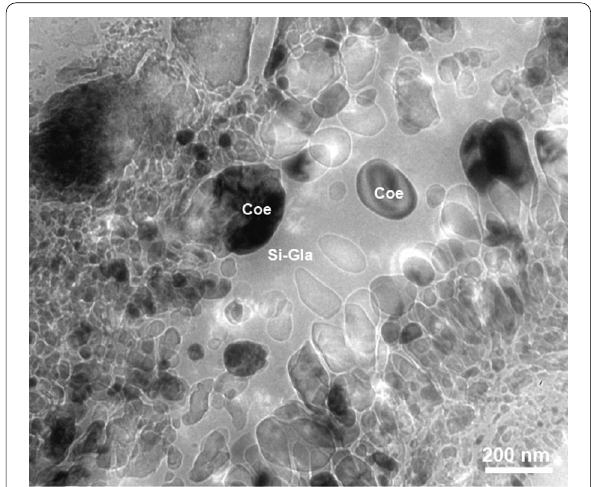
Fig. 10 BF-TEM image of coesite in the eucrite Béréba. Spherical coesite crystals have formed in cristobalite or tridymite grains in contact with the shock-melt veins of Béréba. A part of the original silica has become amorphous. Coe: coesite, Si-Gla: